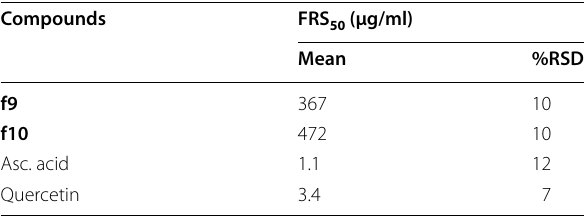
Table 47 Free radical scavenging (FRS pyrido[2,3- d ]pyrimidines (f9 and f10) Compounds